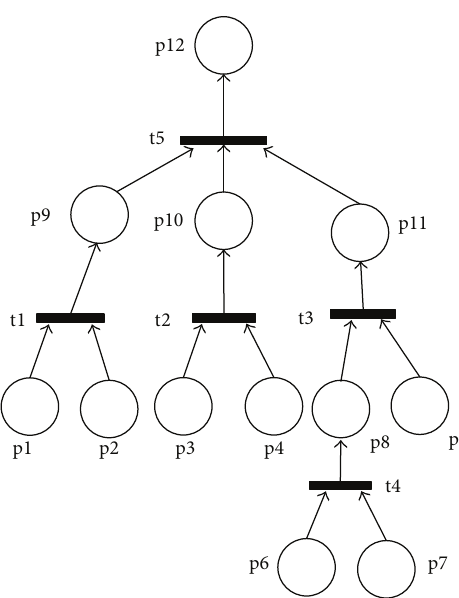
Figure 7: ESPN model of electric vehicle motor.